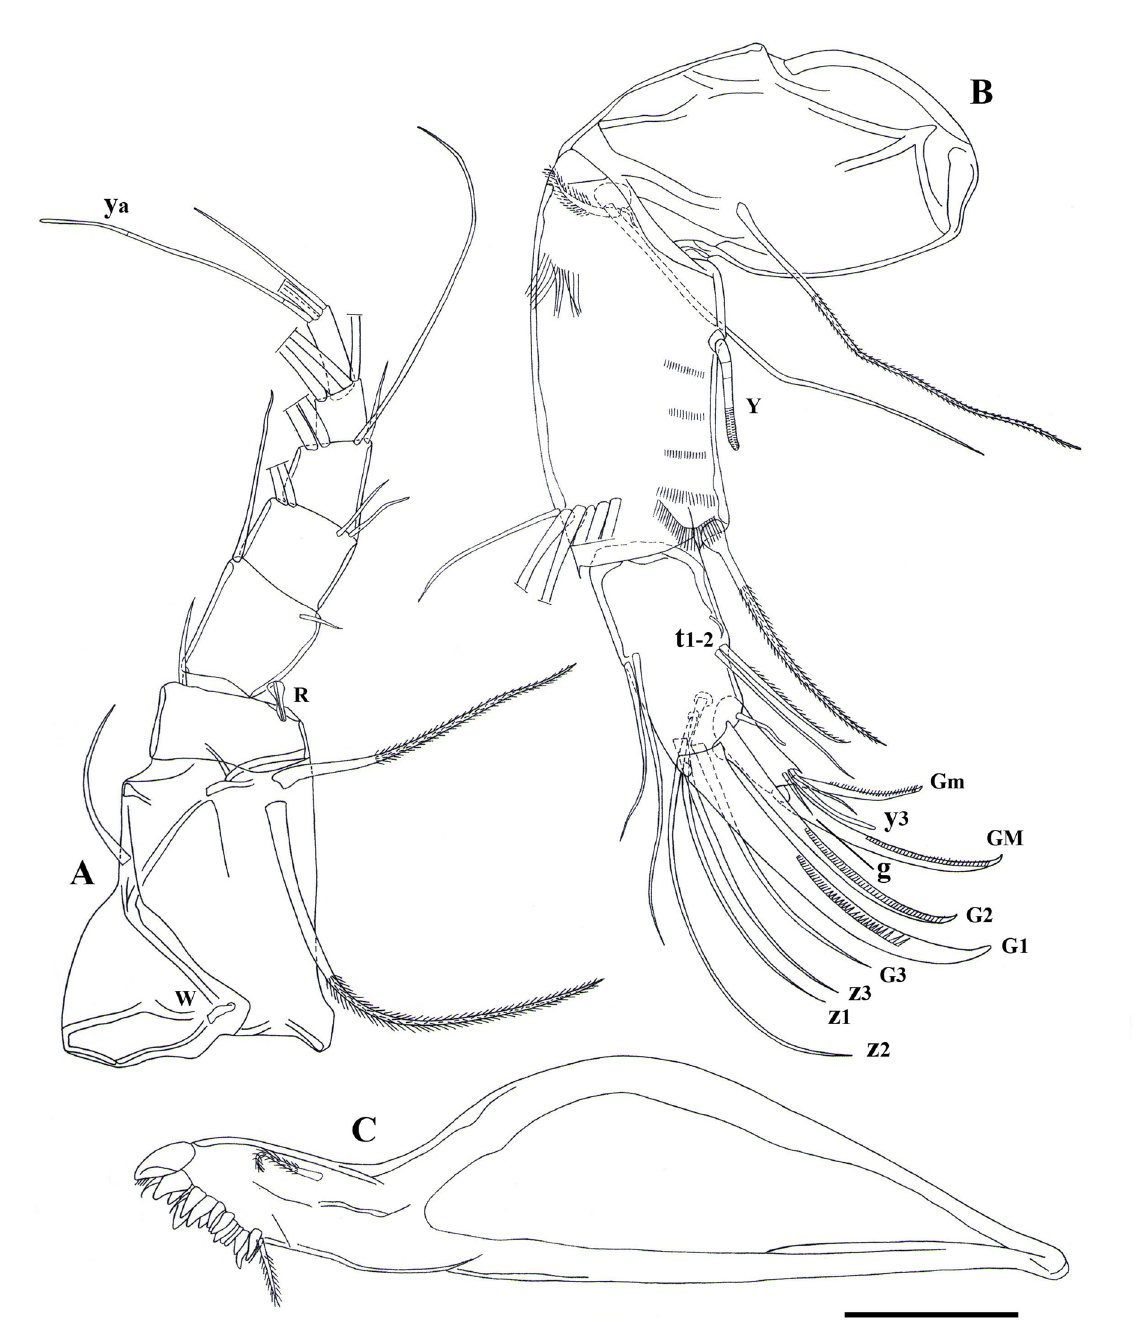
Fig. 16. Siamopsis planitia gen. et sp. nov., ♀ (MSU-ZOC.207). A . A1. B . A2. C . Md coxa. Scale bar: 50